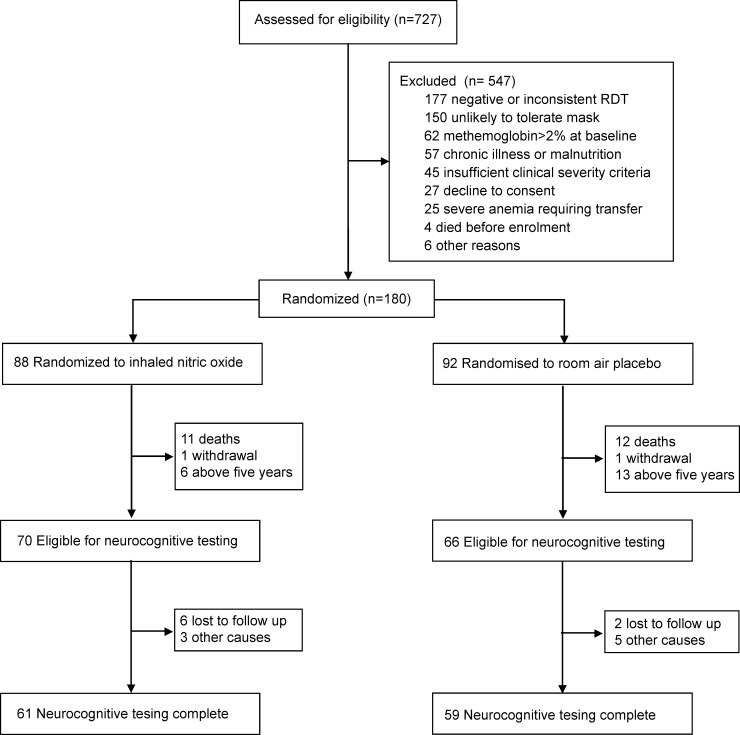
Flowchart of study population.